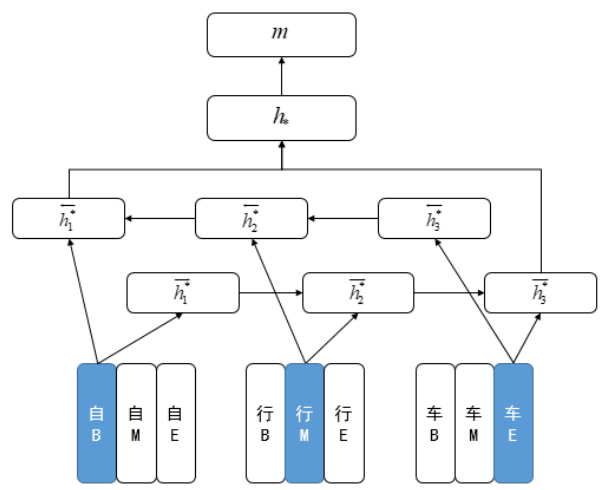
Figure 2. First, select the appropriate character embedding, then input it into LSTM, resulting in the last hidden vectors from each of the LSTM components and concatenate